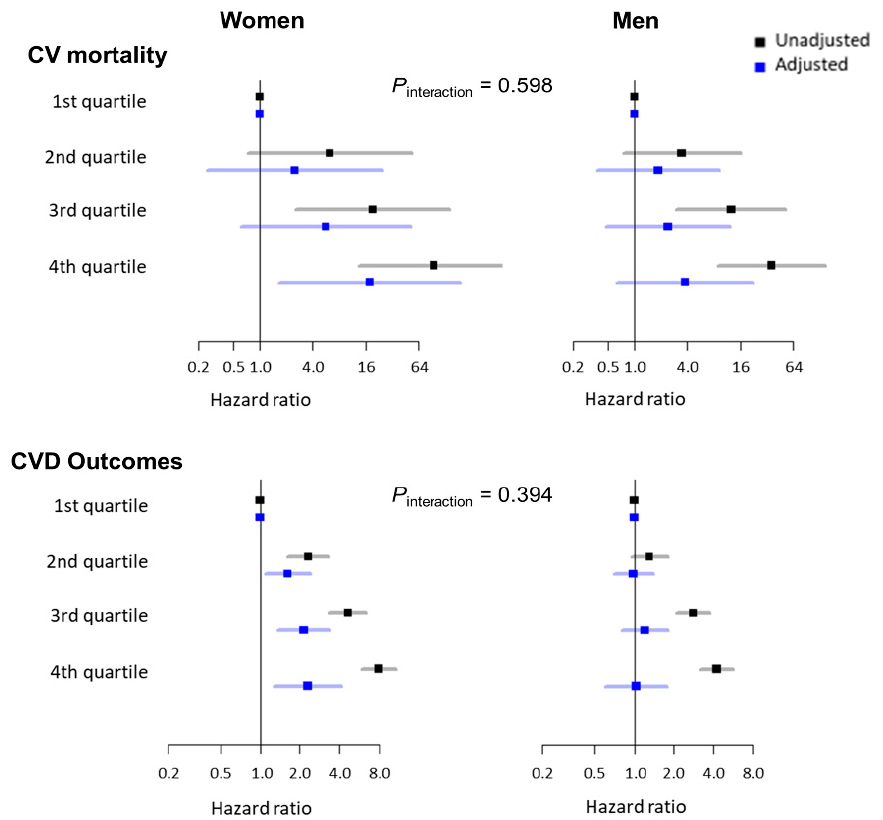
Figure 2. Unadjusted and adjusted association between the ePWV and CV mortality and CVD outcomes according to sex. ePWV, estimated pulse wave velocity; CV, cardiovascular; CVD, cardiovascular disease. Hazard ratios were adjusted for age, systolic blood pressure, smoking status, alcohol drinking status, physical activity, income level, educational status, body mass index, waist circumference, medical history (hypertension, diabetes mellitus, and dyslipidemia), estimated glomerular filtration rate, fasting blood glucose level, total cholesterol level, and low-density lipoprotein cholesterol level.